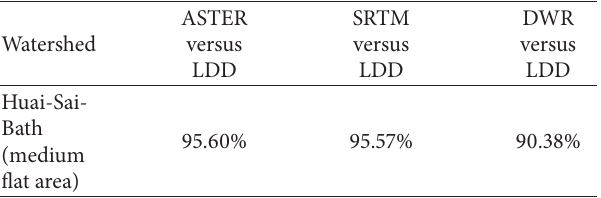
Table 6: Intersected area between various DEMs extracted from Huai-Sai-Bath subbasin.